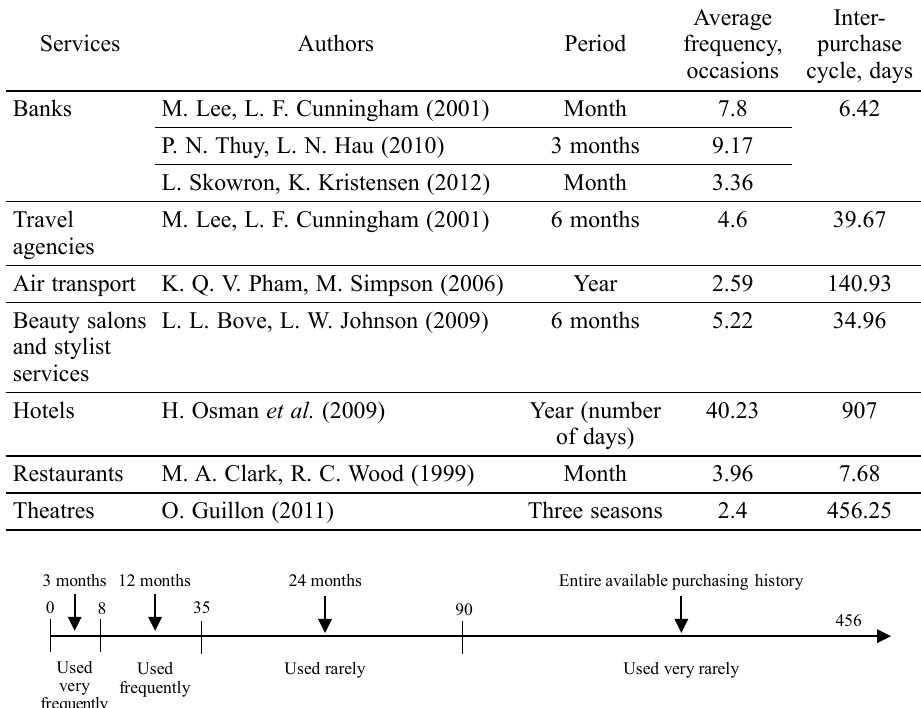
Table 2. The frequency of using the inter-purchase cycle of services in separate sectors